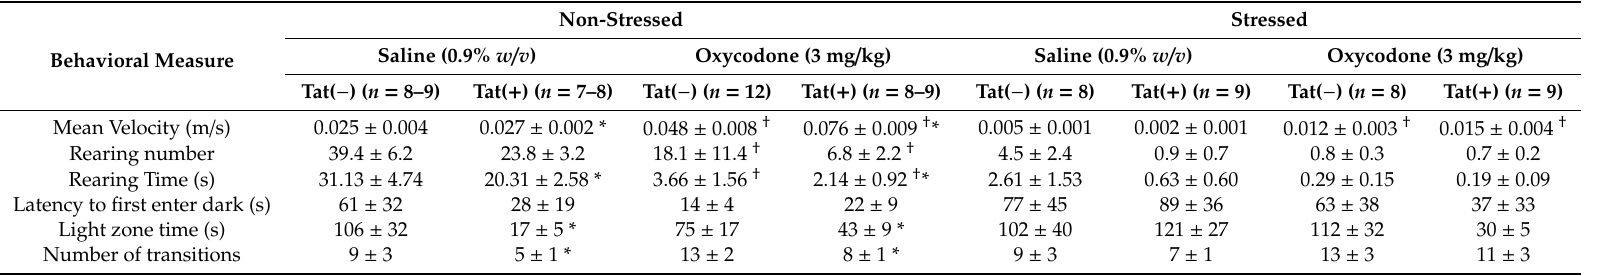
Table 1. Motor measures acquired in an open field and anxiety-like / motor measures acquired in a light-dark transition task from Tat( − ) and Tat( + ) males that were exposed (or not) to a 15-min forced swim stress prior to administration of saline or oxycodone. * indicates a main e ff ect of genotype wherein Tat( + ) mice di ff er from Tat( − ) controls. † indicates a main e ff ect for oxycodone to di ff er from saline administration, p ≤